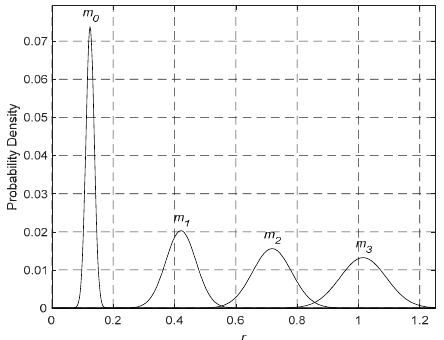
Figure 1. Conditional probability density functions (CPDF) of a PAM-4 signal, within signal-dependent noise.